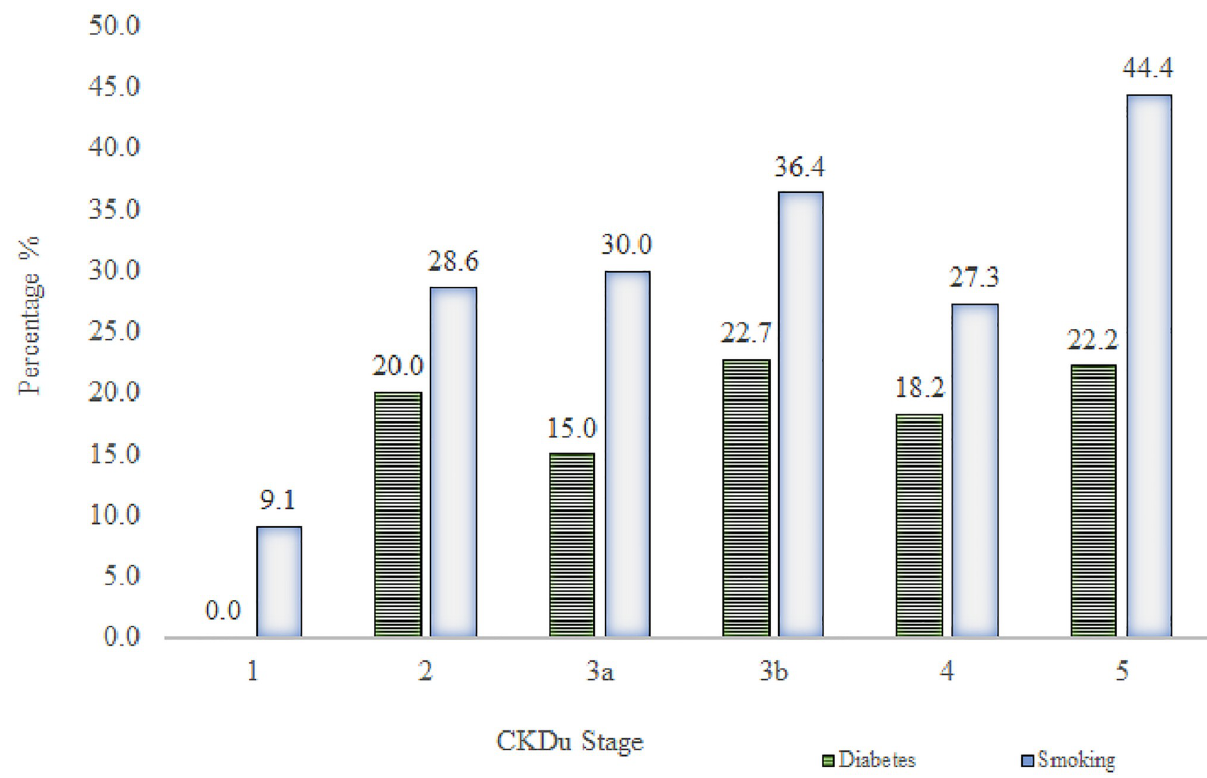
Fig 3. Prevalence of diabetes and smoking in different CKDu cases. Total bar height reflects the percentage of diabetes (HbA1c � 6.5% or a history of diabetes, which was developed after the diagnosis of CKDu) and smoking in each stage of CKDu.